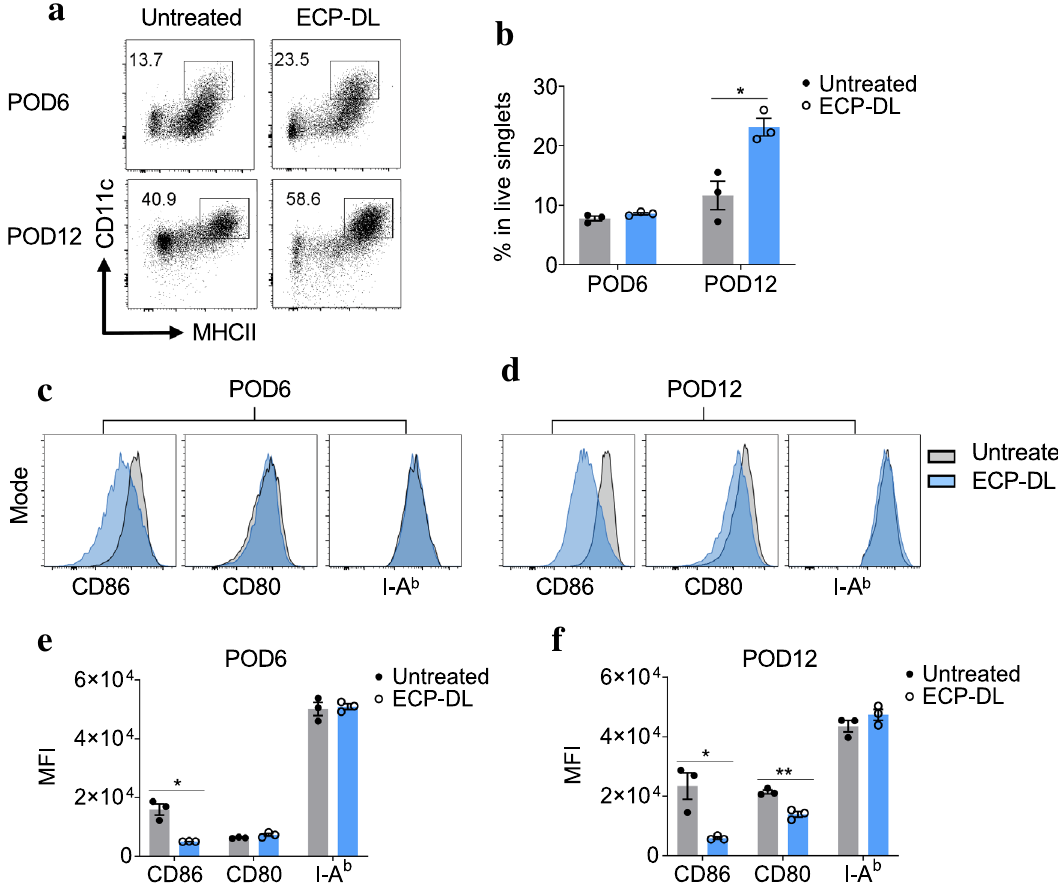
Figure 5. ECP-DL infusion increased the percentage of tolerogenic host dendritic cell infiltrates in heart allografts. Both groups underwent heterotopic heart transplants and either received ECP-DL on day -7 or no therapy; animals were sacrificed on POD6 or 12; heart grafts infiltrating cells were isolated and subjected to flow cytometry analysis (n = 3/group). Cells were gated on H-2b + (host) CD11b + live single cells. ( a, b ) Representative dot-plots and bar graphs showing the percentage of host-derived dendritic cells infiltrating in the graft at POD6 and POD12. * p < 0.05 by student t -test. ( c, d ) Representative histogram and ( e, f ) corresponding bar graphs of CD86, CD80, and MHCII (I-A b ) expression of graft-infiltrating dendritic cells. Host-derived dendritic cells isolated from the grafts in ECP-DL treated mice express significantly lower levels of CD86 at both POD6 and POD12. MFI: Mean fluorescence intensity; * p < 0.05, ** p < 0.01 by student t